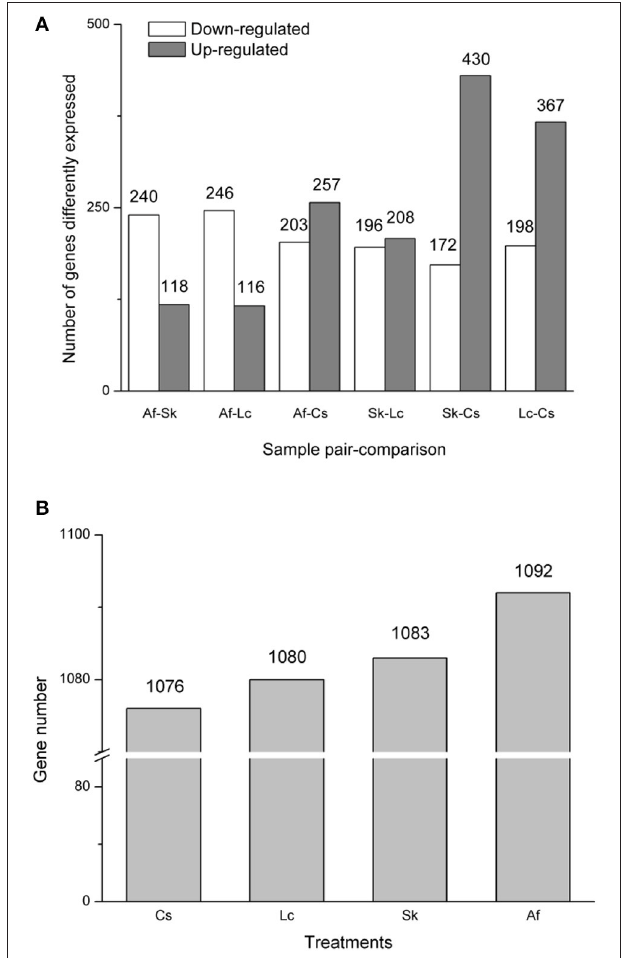
FIGURE 1 | (A) The distribution of differentially expressed genes (DEGs). The X-axis indicates treatment-vs.-treatment, while the Y-axis indicates the number of the DEGs. The gray bar indicates up-regulated genes, while the white bar indicates down-regulated genes. (B) The total numbers of differently expressed genes. All genes were at q < 0.005, |log2.Fold_change| >